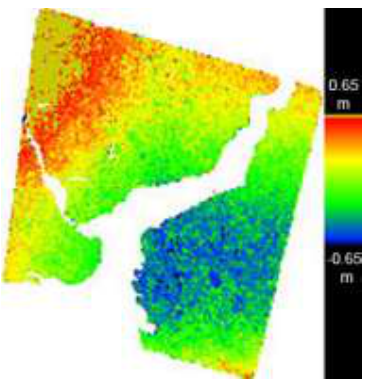
Figure 9. Averaged y-parallaxes, Kompsat-3 stereo model